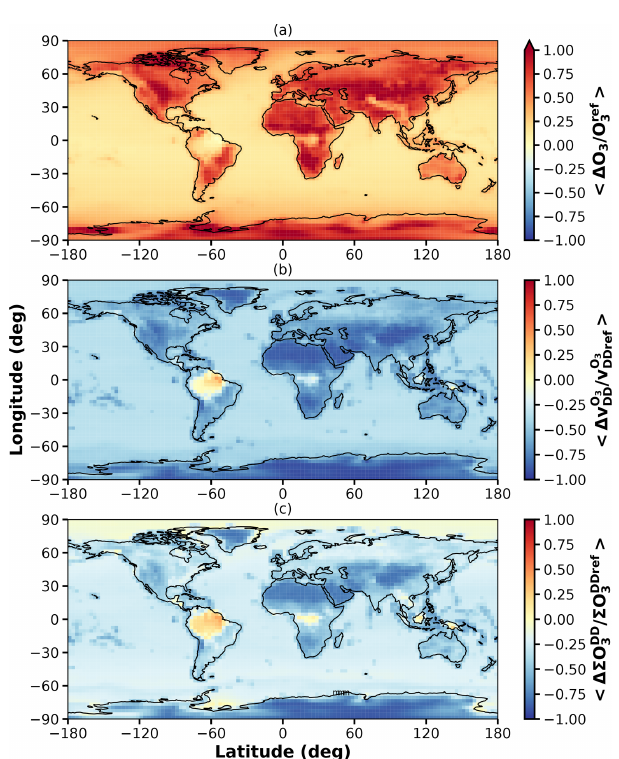
Figure 4. Relative difference between reference simulations mO- Saic and the Wesely_type with respect to (a) average surface ozone; (b) average ozone dry deposition velocity; (c) total amount of ozone removed from the atmosphere by dry